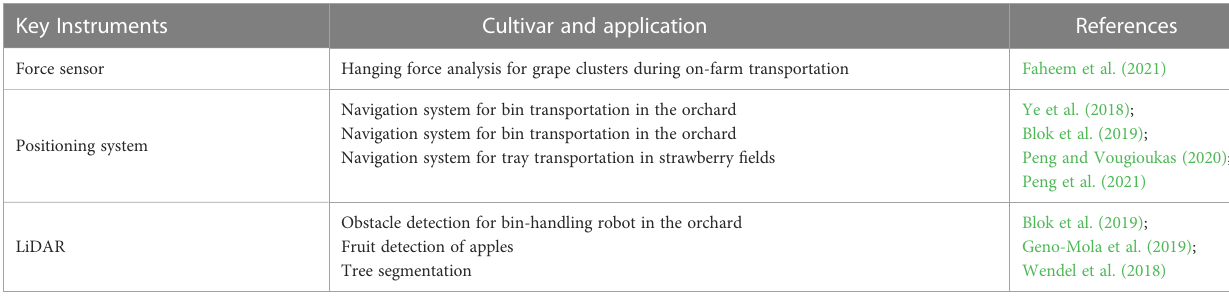
TABLE 3 Key instruments required for on-farm transportation data acquisition.